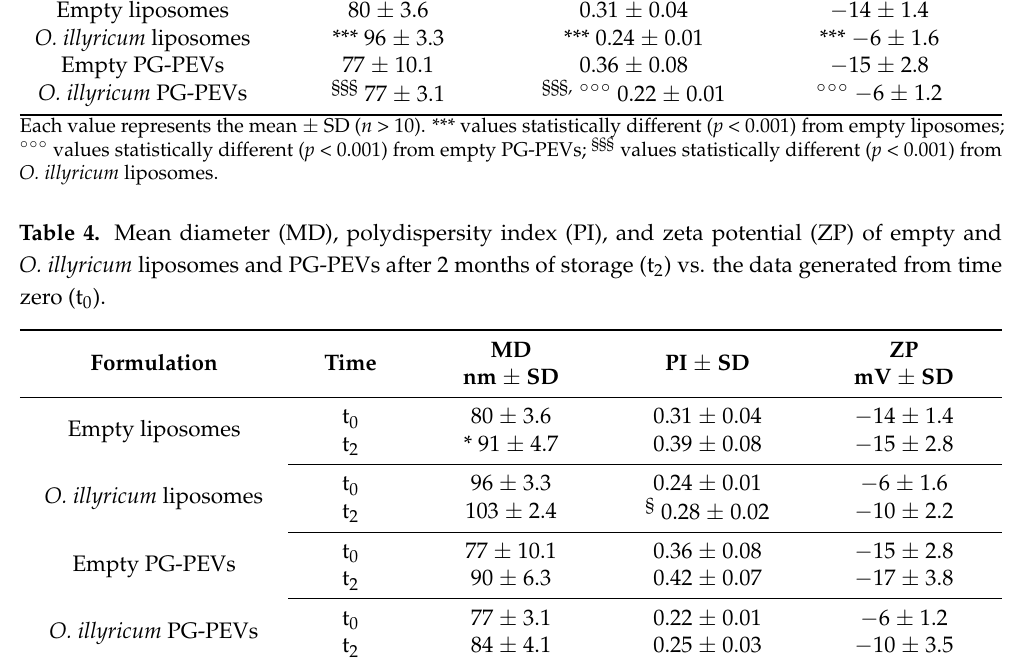
Table 3. Characteristics of empty and O. illyricum liposomes and PG-PEVs: mean diameter (MD), polydispersity index (PI), and zeta potential (ZP). Formulation